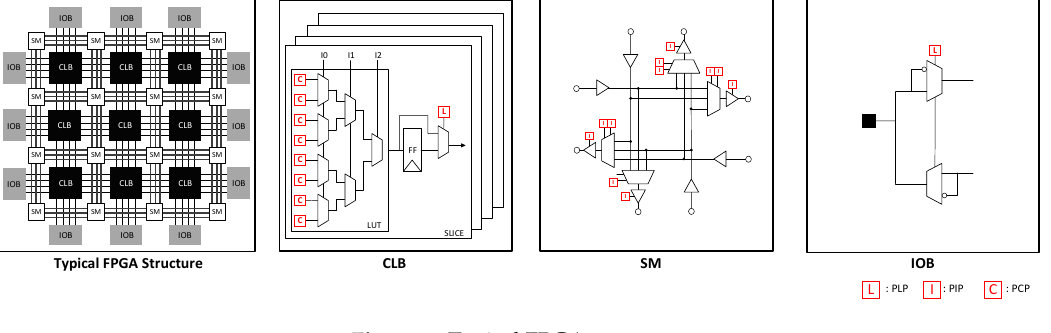
Figure 1. Typical FPGA structure.